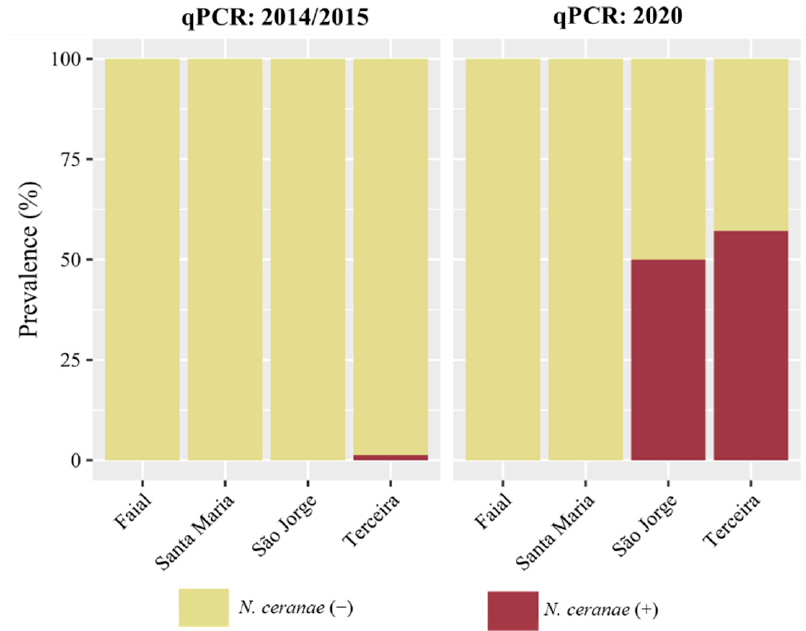
Figure 3. N. ceranae prevalence result of qPCR in 2014/2015 compared with 2020.